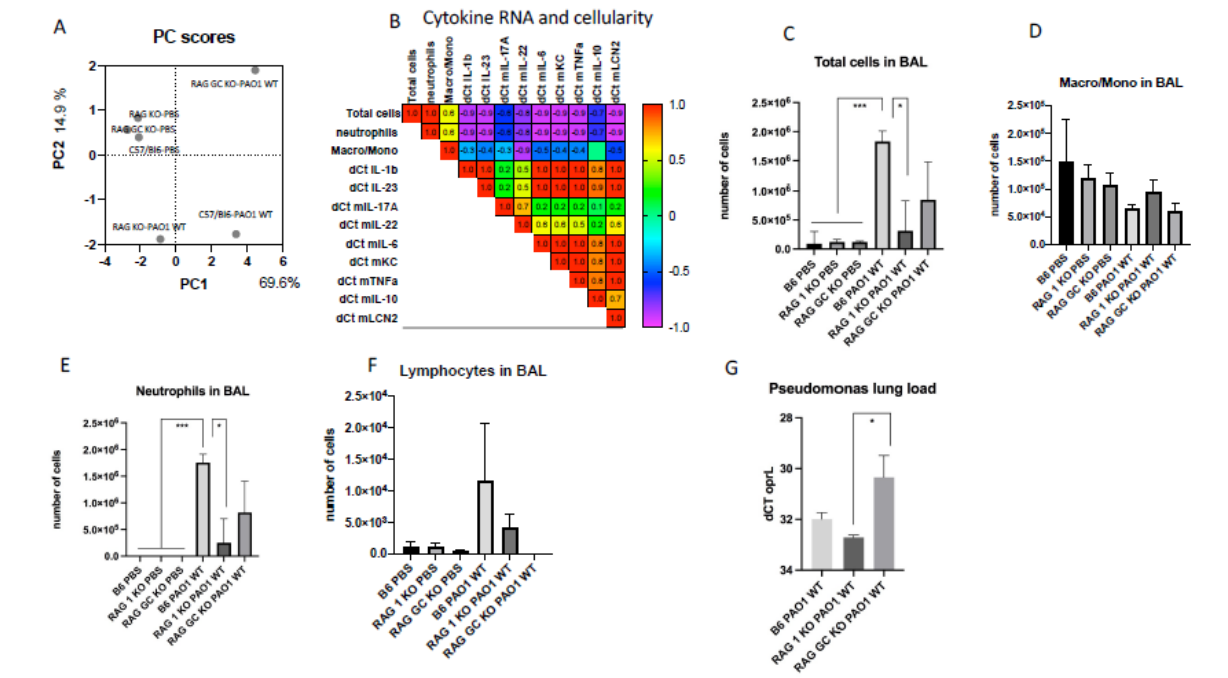
Figure 2. Cytokine RNA expression and lung inflammation post- P. aeruginosa infection. ( A ) C57/Bl6 WT, RAG KO and RAG γ C double KO mice were infected intra-nasally with 1.4.10 7 cfu of PAO1 ( n = 5 in each group) or mock-treated with PBS ( n = 3 in each group); 16 h later lungs were recovered for RNA assessment (RT-qPCR) and BAL performed for differential cell analysis (cytospins). An unbiased multivariate principal component analysis (PCA) global analysis, encompassing all 24 mice, was performed with the following variables: ‘total BAL cell numbers’, ‘total neutrophils’, total ‘monocytes/macrophages’, and IL -1b, KC, IL-17, IL-23, IL-6, IL-22, TNF, IL-10 lung RNA expression. ( B ) A correlation matrix was analyzed, plotting cytokine RNA levels (expressed as dCt. = Ct ‘mediator’ -Ct 18S) and BAL cellularity. NB: the correlations between cytokine RNA levels and cells, although positive, appear artefactually negative (blue/purple color in the matrix) only because the value of dCT, the chosen RNA expression unit, is inversely proportional to gene expression. The numbers in the squares represent the r correlation value. ( C – F ) BAL cell cellularity is shown in each individual experimental group. ( G ) PAO1 load was assessed by RT-qPCR, using oprL (peptidoglycan associated protein) primers, a method previously validated (see Materials and Methods). NB: to reflect that dCT, the chosen RNA expression unit, is inversely proportional to gene expression, the units of the Y axis have been reversed for a more intuitive representation (dCT 34 to 28). Statistical significance was assessed with ANOVA test, followed by Tukey post hoc multivariate analysis. * p < 0.05; *** p < 0.005.